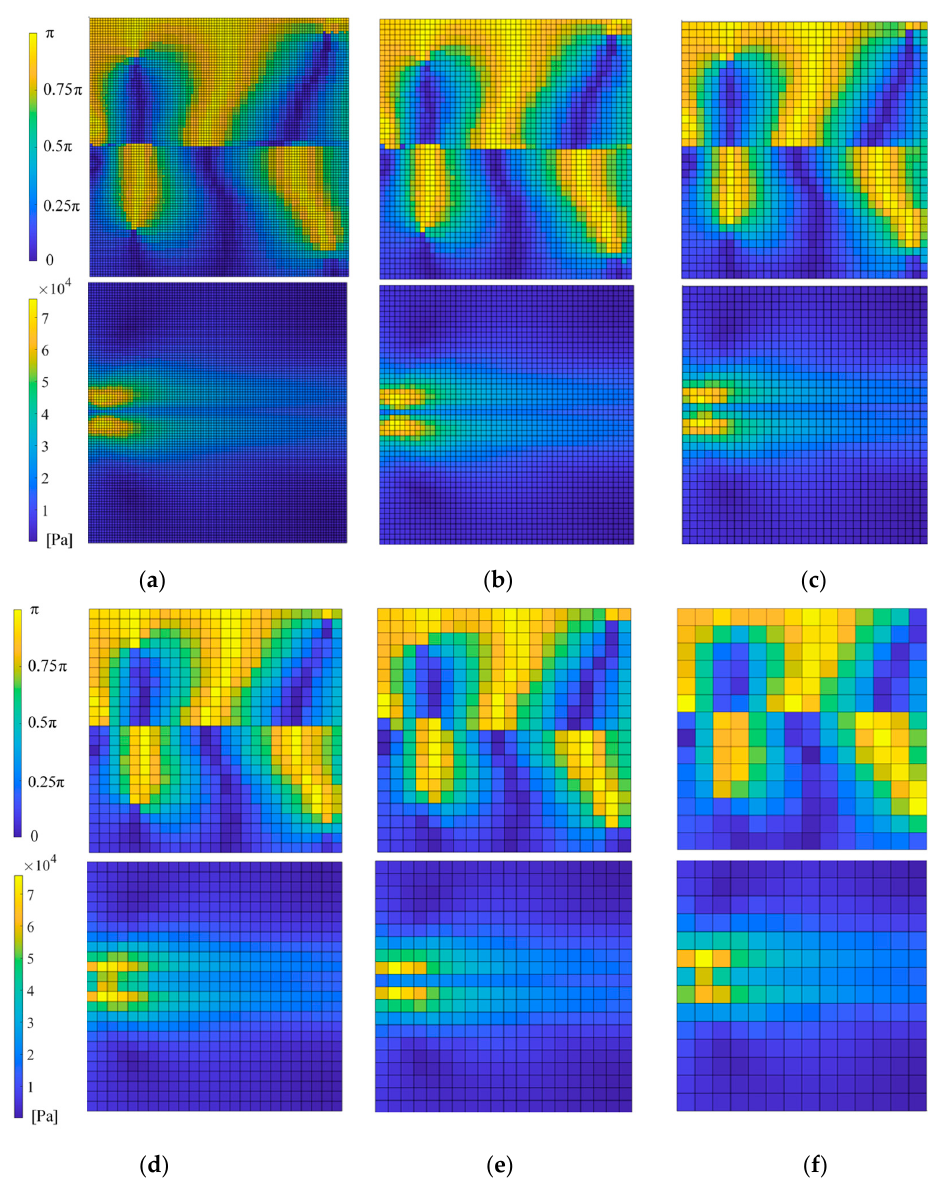
Figure 11. The graphics resolution of different c s values. ( a ) c s = 0.145 (number of points: 101 × 101). ( b ) c s = 0.290 (number of points: 51 × 51). ( c ) c s = 0.435 (number of points: 34 × 34). ( d ) c s = 0.580 (number of points: 26 × 26). ( e ) c s = 0.725 (number of points: 21 × 21). ( f ) c s = 1.000 (number of points: 15 × 15).